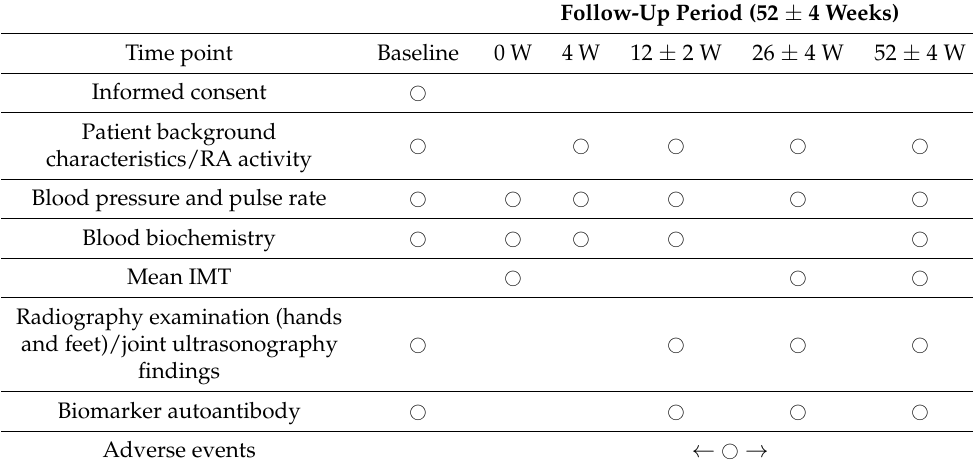
Table 2. Data Collection